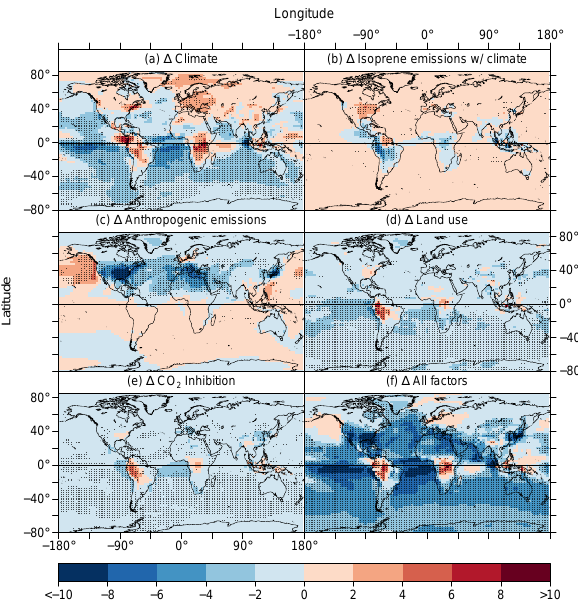
Fig. 5. Changes in five-year mean near-surface ( < 720m) O 3 in five year mean near surface ( < 720 m) O Fig. 5. Changes (2095–2000) caused by different environmental variables. Changes environmental variables. Changes are considered significant (stippled) if they are greater than are considered significant (stippled) if they are greater than 2 times 2 times the standard deviation for the five year mean (i.e. approximately the 5 % level). the standard deviation for the five-year mean (i.e. approximately the 5%